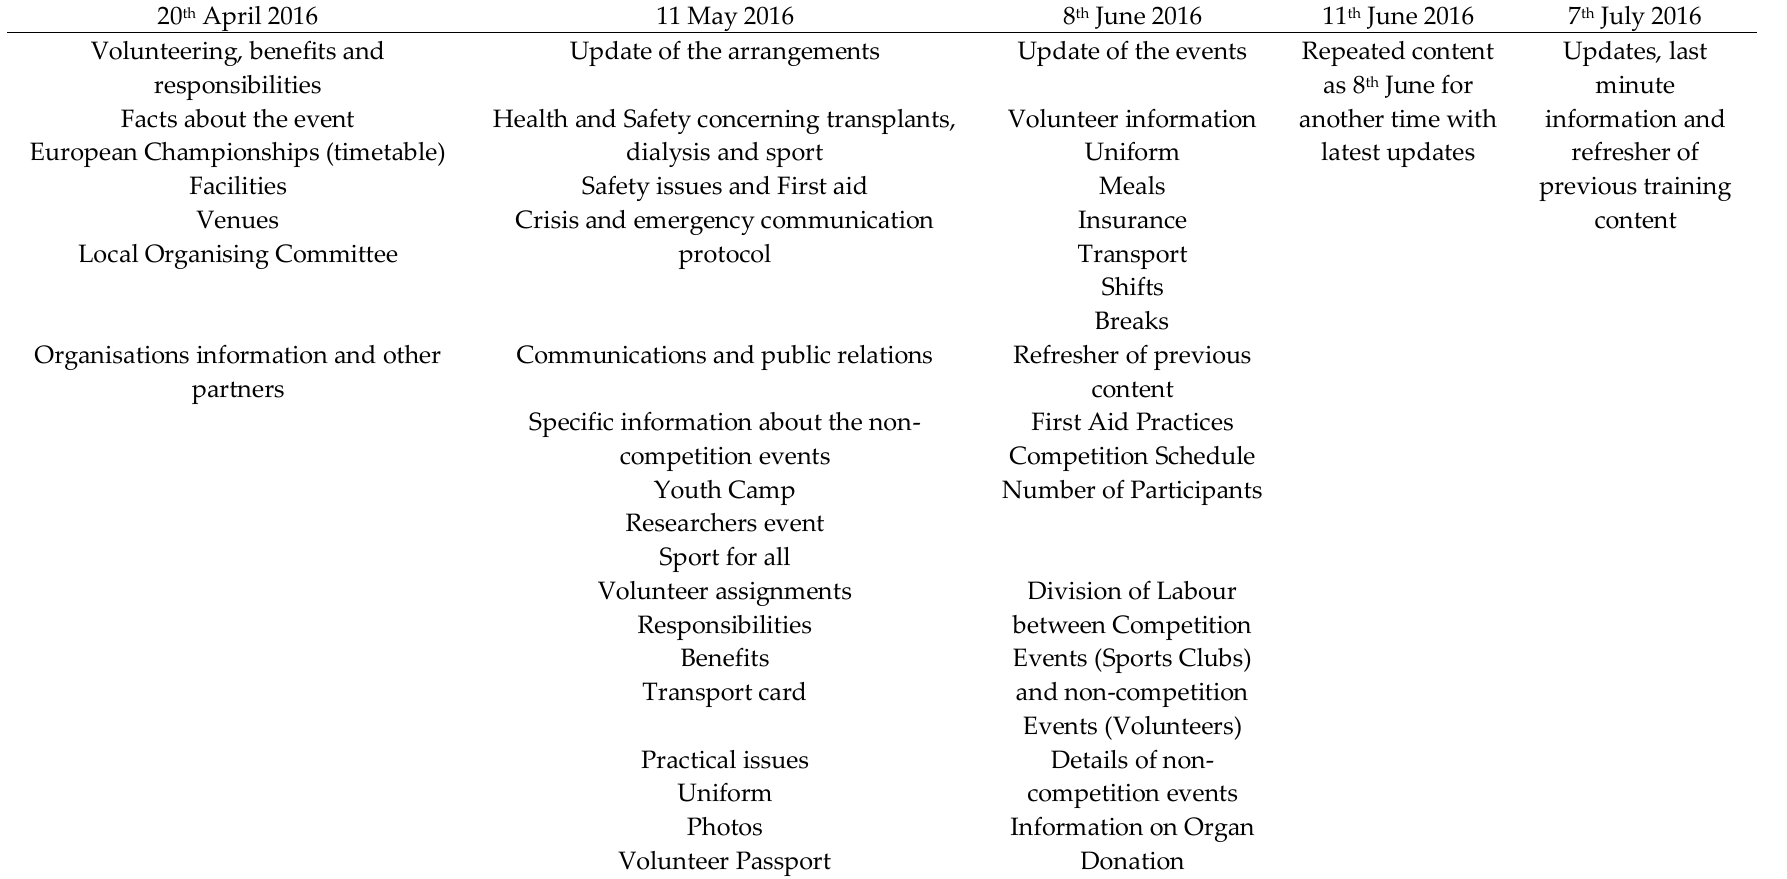
Table 1. European Transplant Sports Week Generic Volunteer Training Content